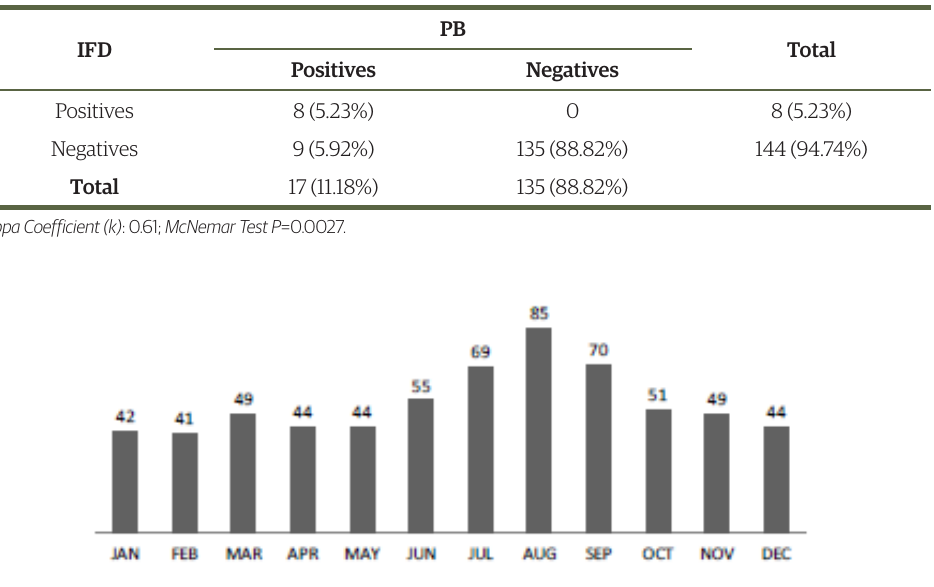
Figure 2. Monthly distribution of samples (N=643) received from January 2001-2015 at the Zoonosis Diagnostic Service – SDZ – FMVZ – UNESP – Botucatu – Sao